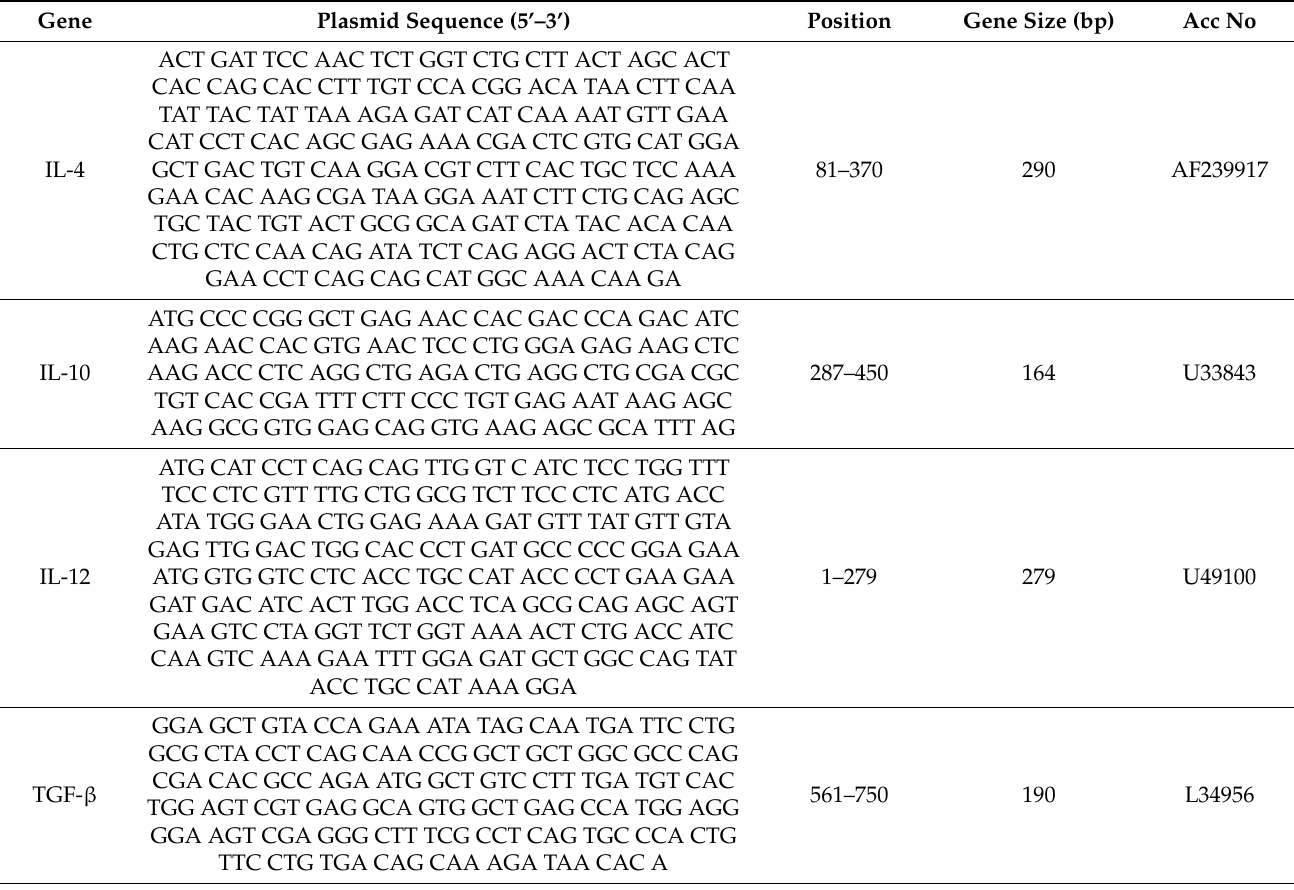
Table 4. Plasmids used for generation of standard